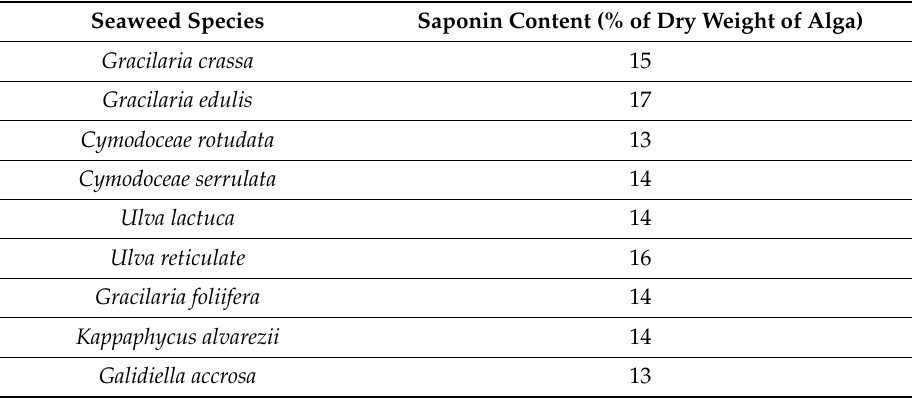
Table 5. Saponin content of di ff erent seaweed